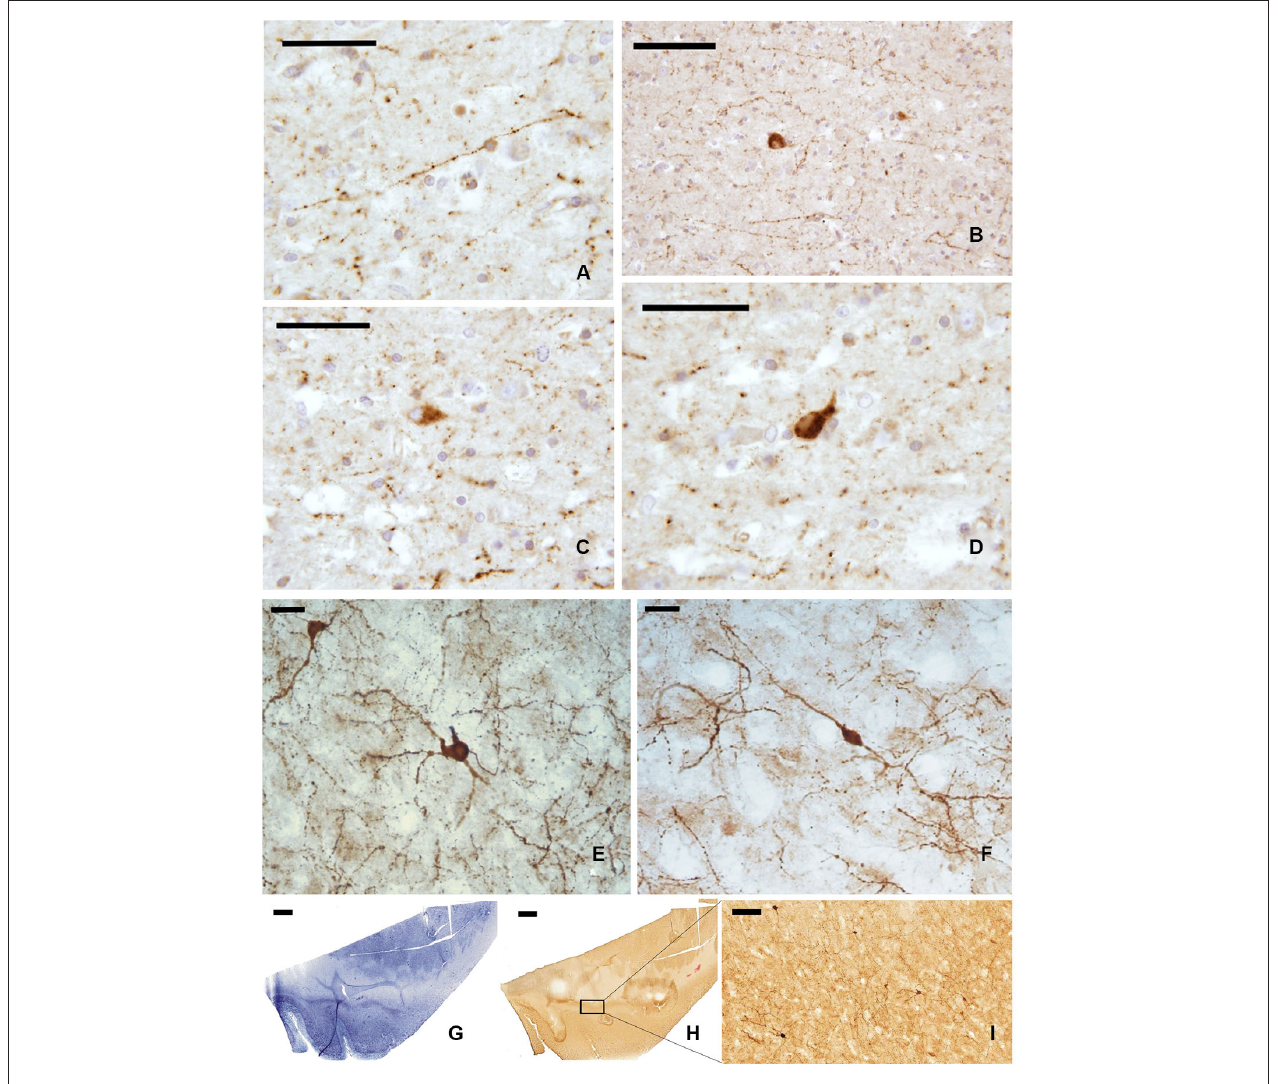
FIGURE 4 | NPY-ir fibers (A, B) and neurons (C, D) in paraffin-embedded sections of the claustrum; (E, F) NPY positive neurons in frozen sections; (G–I) localization of NPY-ir neurons in whole sections ((G) Nissl stain,